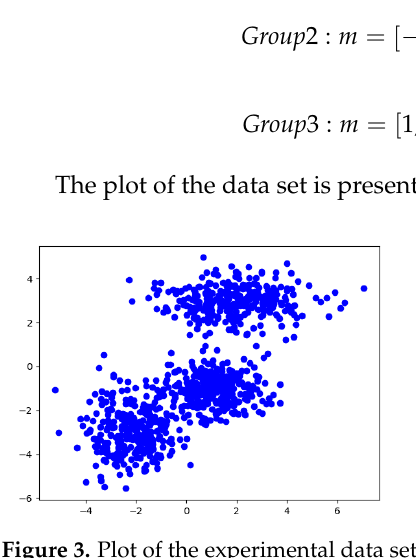
Figure 3. Plot of the experimental data set.